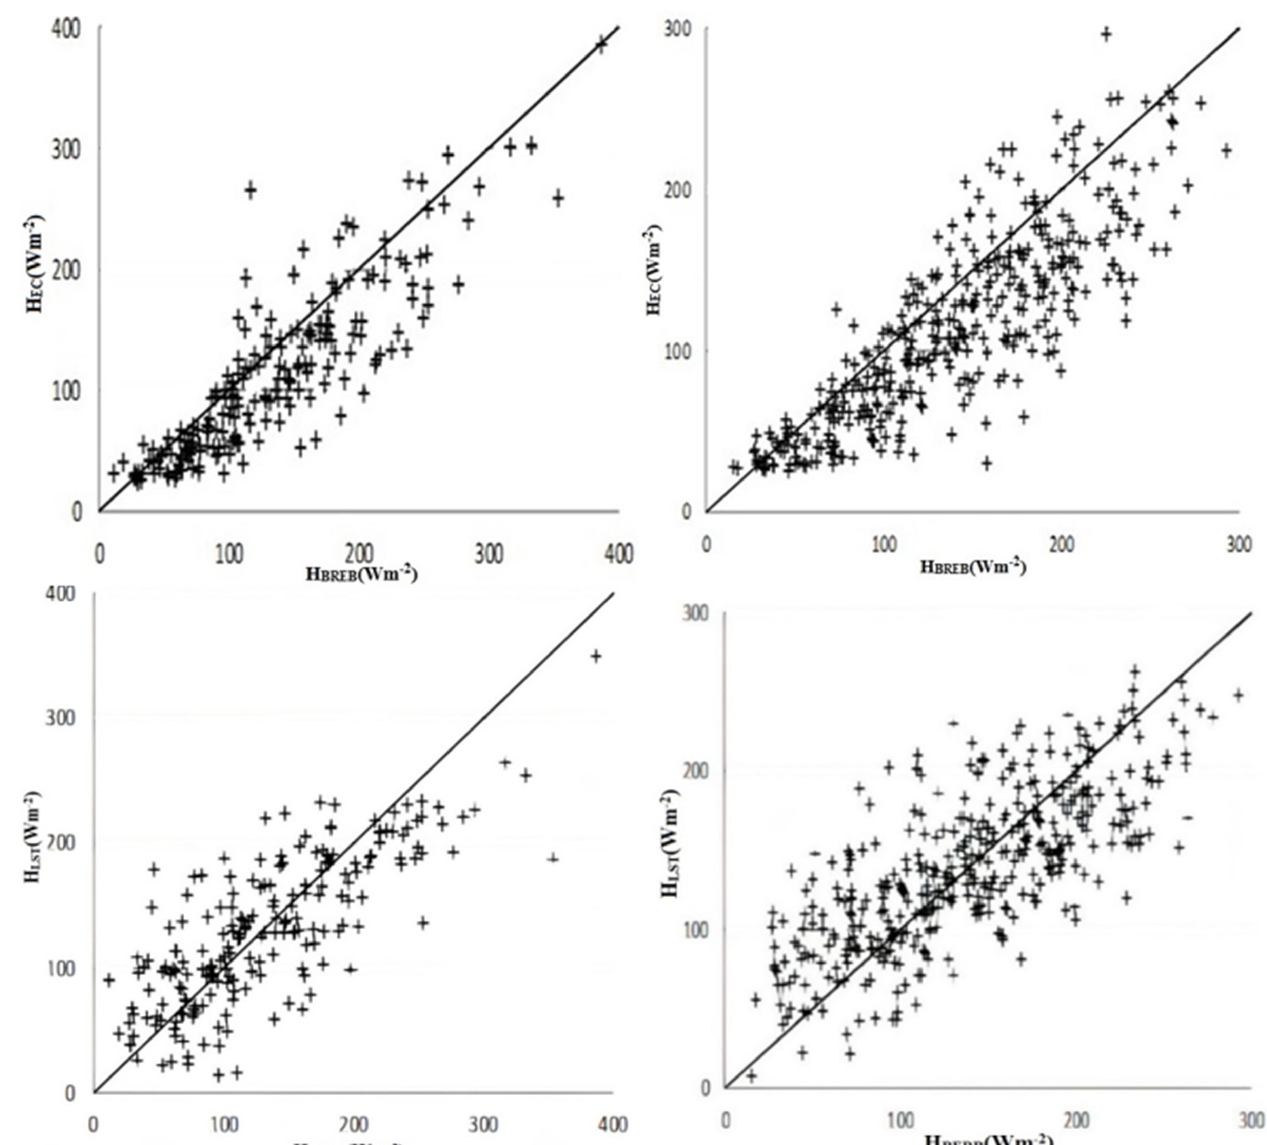
Figure 2. Sensible heat flux determined using the EC method (upper panel) and the LST method (lower panel) against the BREB method in July (left panel) and August (right panel).